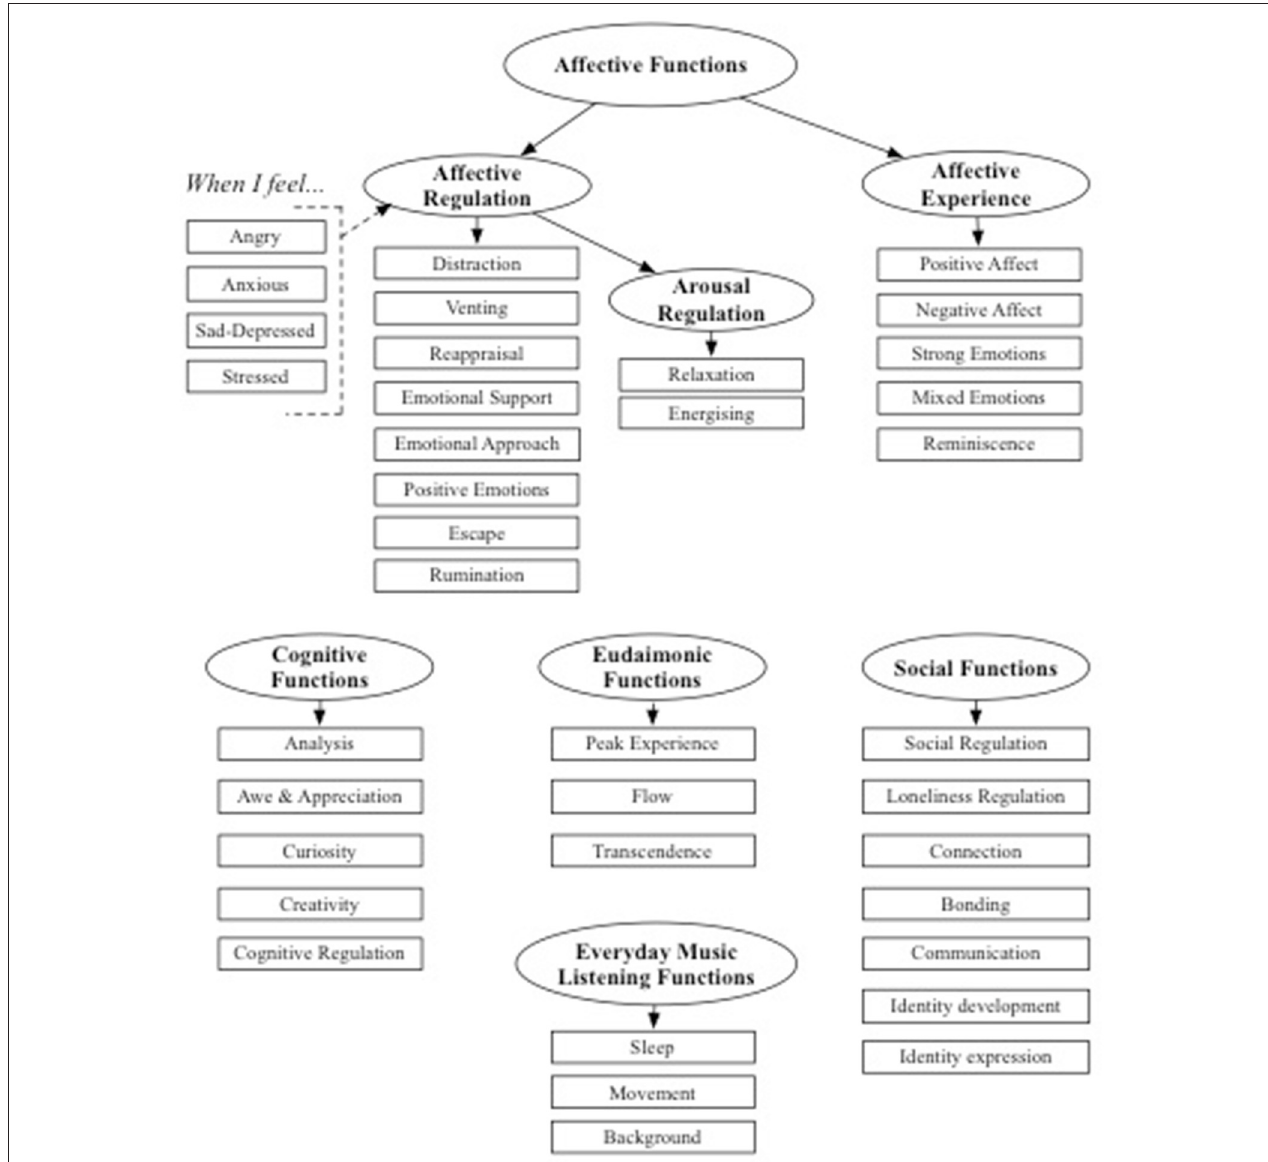
FIGURE 2 | Conceptual structure informing development of the adaptive functions of music listening